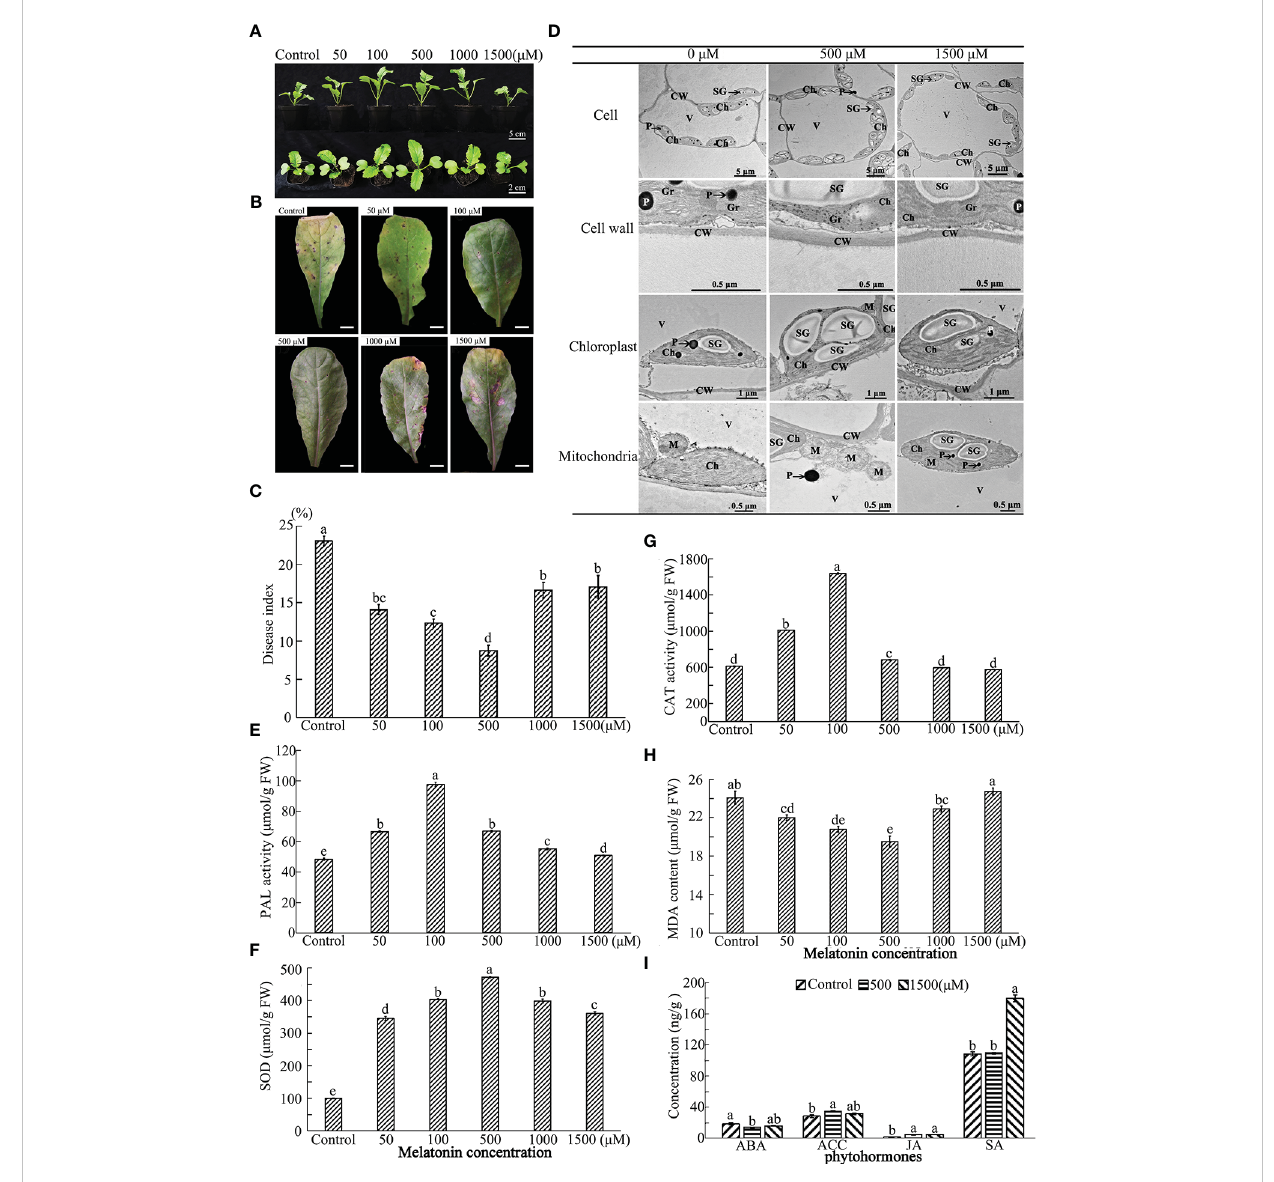
FIGURE 1 Effect of exogenous MT on growth and immunity of radish “ JNYB ” seedlings. Radish 20-day-old seedlings were pretreated with solvent (control) and 50- 1500 m M of MT for 14 days. (A) growth and morphology of radish seedlings pretreated with MT; (B, C) Alternaria blight symptoms and disease index after inoculation of A brassicae on MT-pretreated leaves, bar in B indicates 1 cm; (D) TEM analysis of subcellular structure of leaf cells treated with MT. (E – H) Activity of redox reaction related enzymes for different treatments; (I) Phytohormone concentrations of samples pretreated with MT. CW, cell wall; Ch, chloroplast; Gr, grana; M, mitochondria; SG, starch grains; V, vacuole; P, plastoglobuli. At least three repeats of samples were analyzed; values are means ± standard error (SE); letters indicate signi fi cant difference; statistical analysis was performed by one-way ANOVA, p <